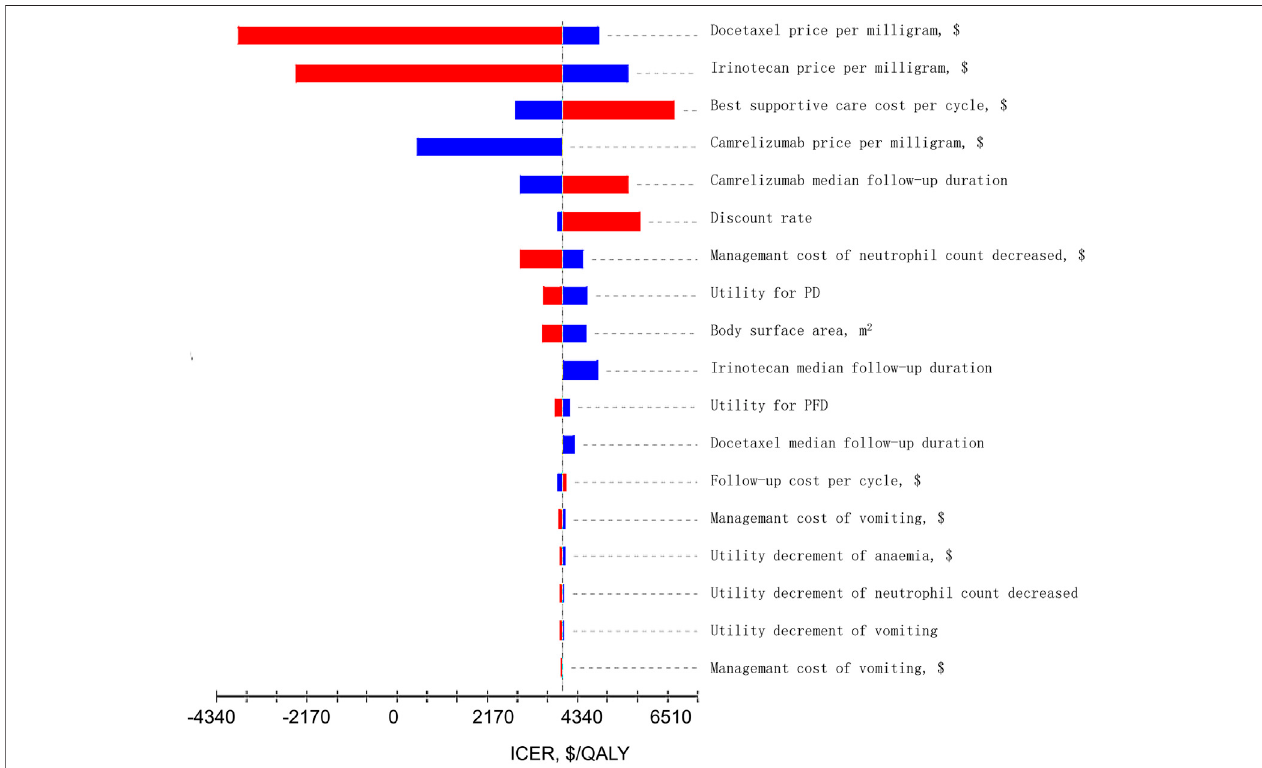
FIGURE 2 | Tornado Diagrams of Univariable Sensitivity Analyses. The dotted line intersecting the red and blue bars represents the ICER of $3,999.00 per QALY from the base case results. The red bars represents the in fl uence of the parameter on the result after the base value rises. The blue bars represents the in fl uence of the parameter on the result after the base value drops.